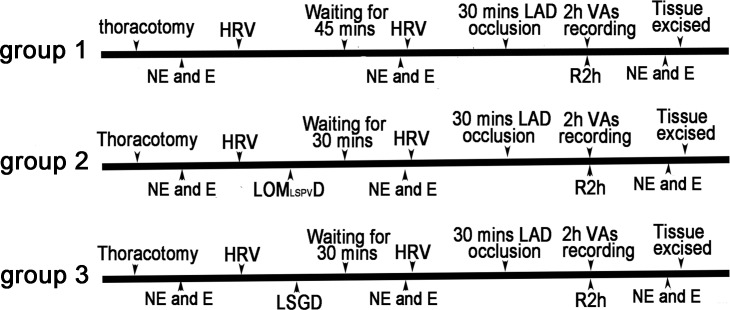
Experimental protocols.IR: ischemia and reperfusion; NE: noradrenaline; E: epinephrine; HRV: heart rate variability; LSGD: left stellate ganglion denervation; LOMLSPVD: LOMLSPV denervation; LAD: left anterior descending coronary artery; Vas: ventricular arrhythmias; R2 h: reperfusion for 2 h.